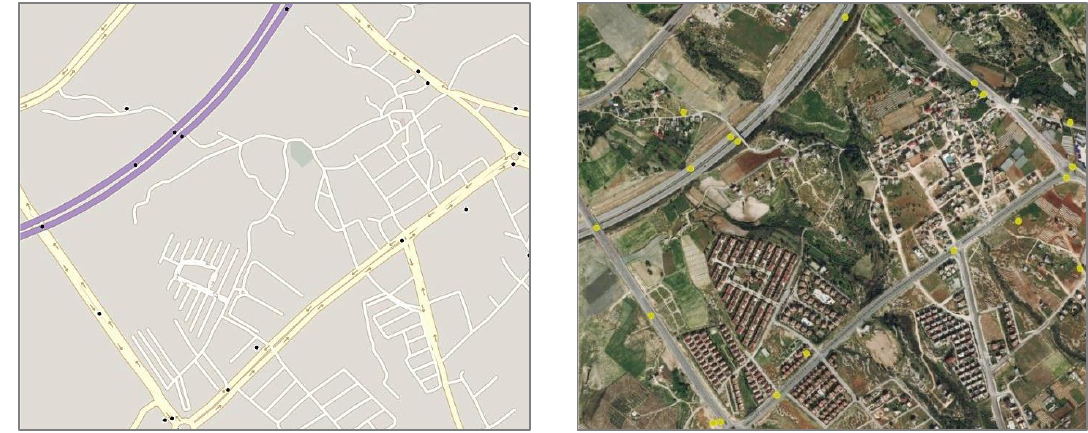
Figure 10 Street Network and Location of Accidents in Kocavilayet Neighborhood